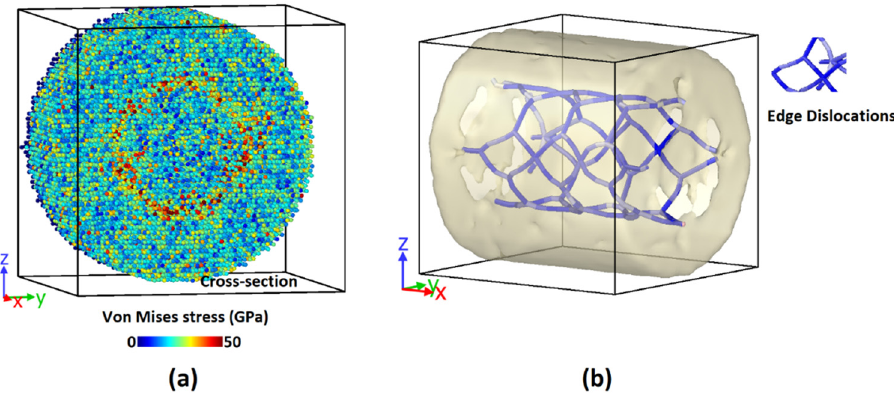
Figure 7: The interfacial region of Ni/Al nanowire sample. ( a ) Stress concentration shown by von Mises stress distribution map and ( b ) perfect dislocations detected by DXA analysis.